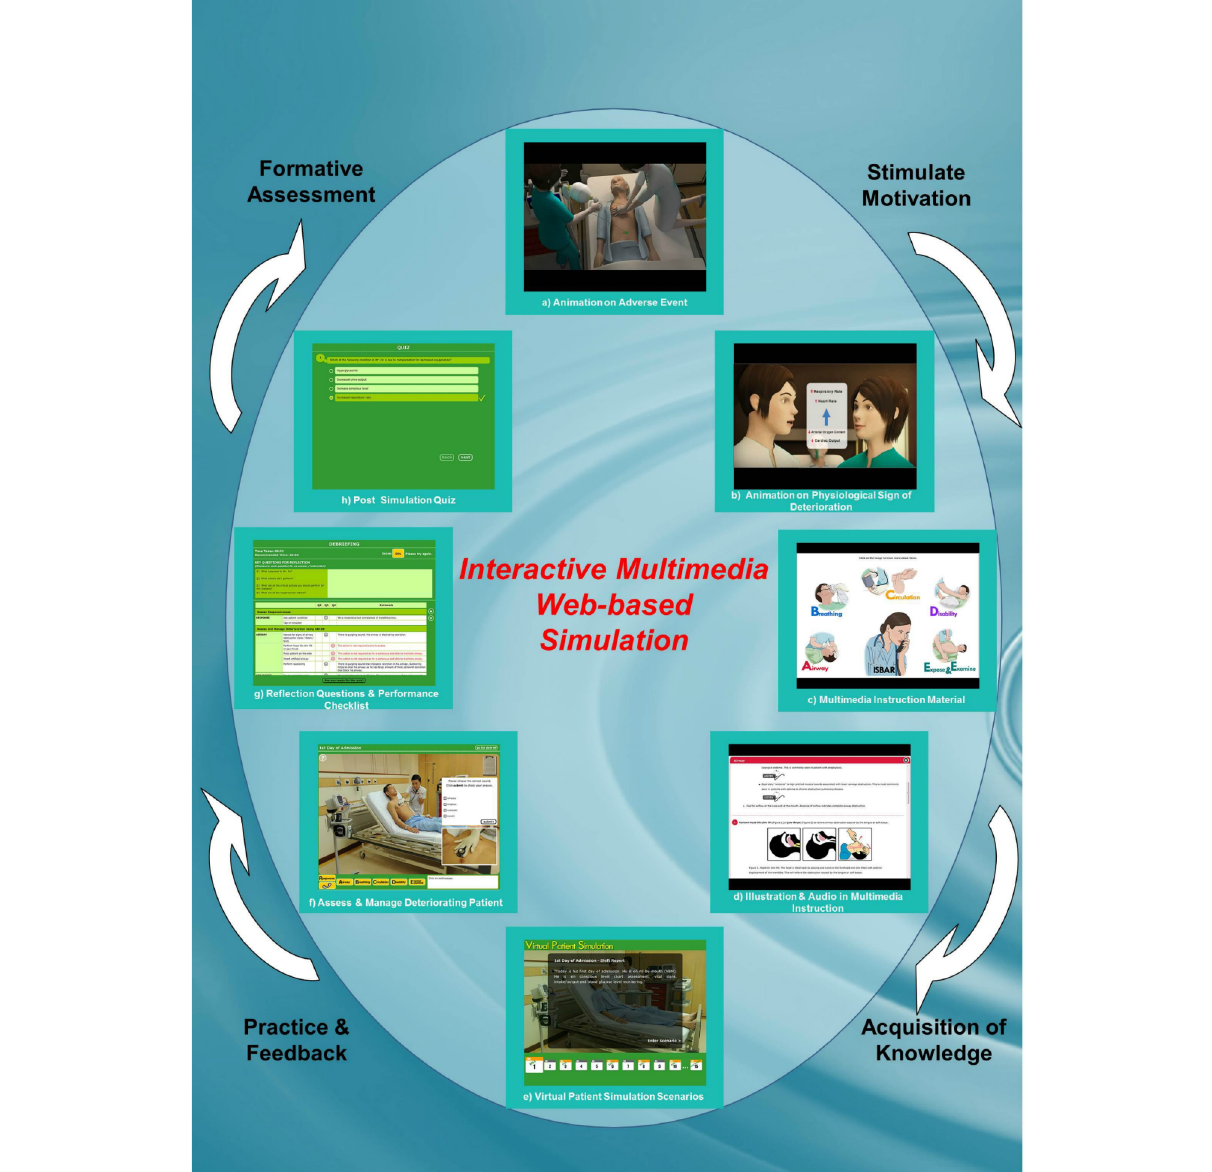
Figure 1. Instructional activities in Web-based